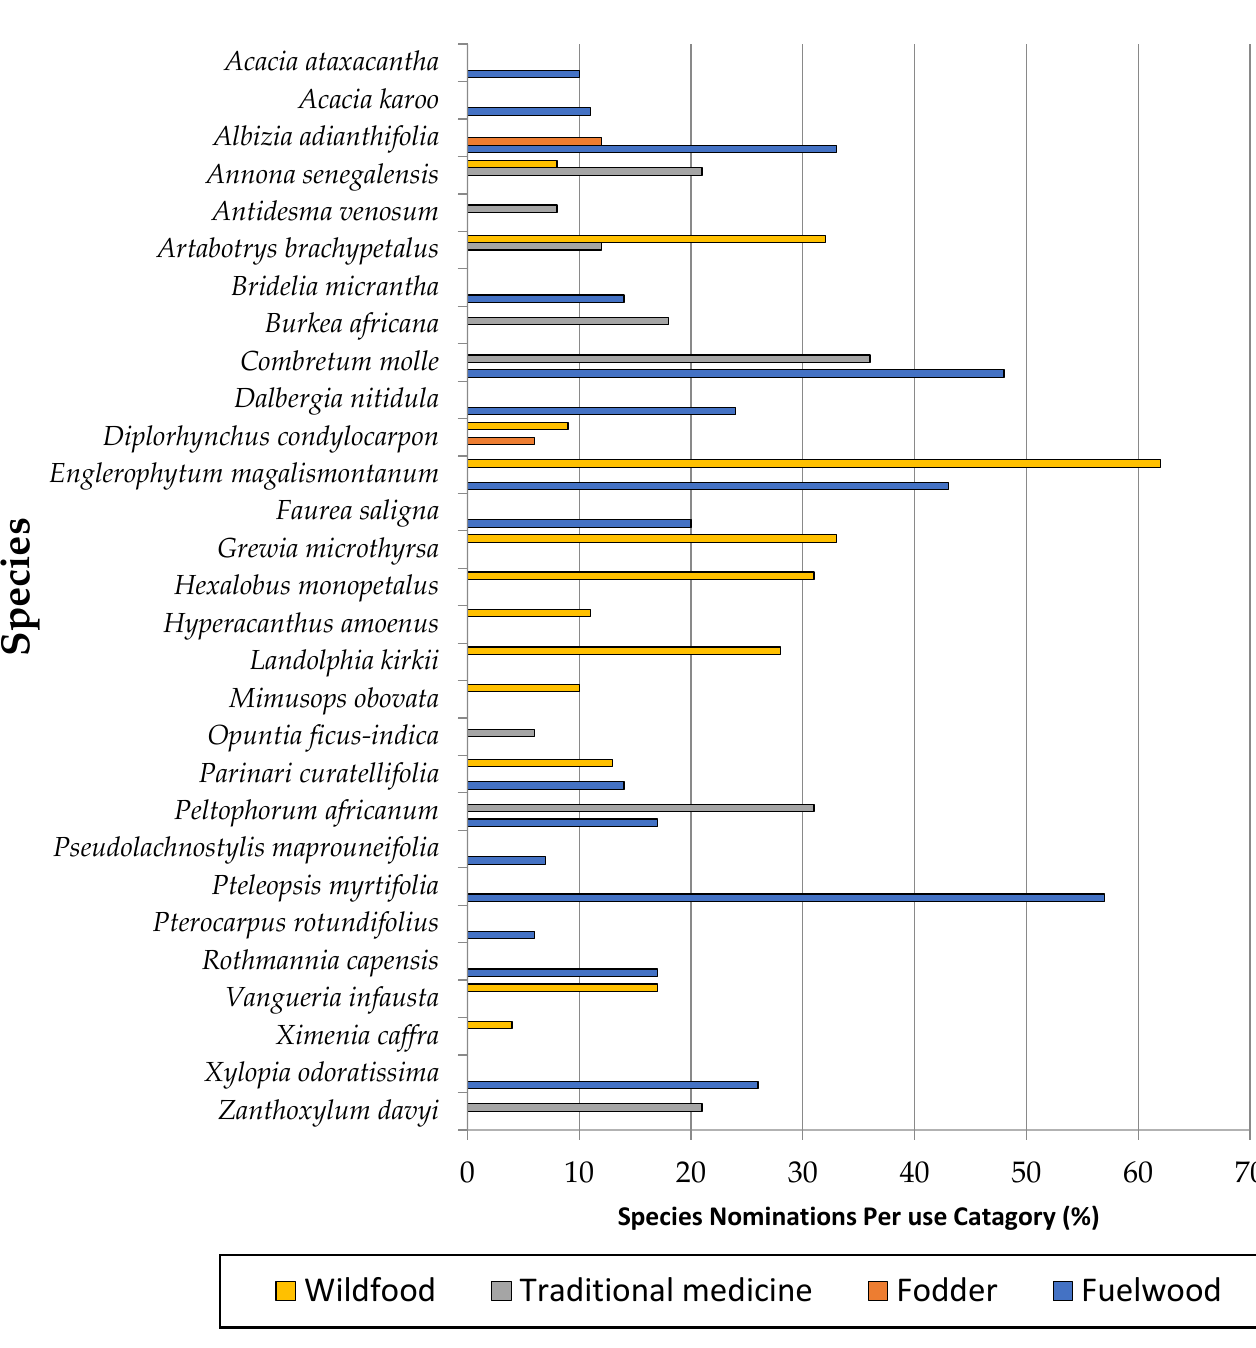
Figure 7. Nominated important tree species per defined utility category, as cited by participants in the focus group discussions.